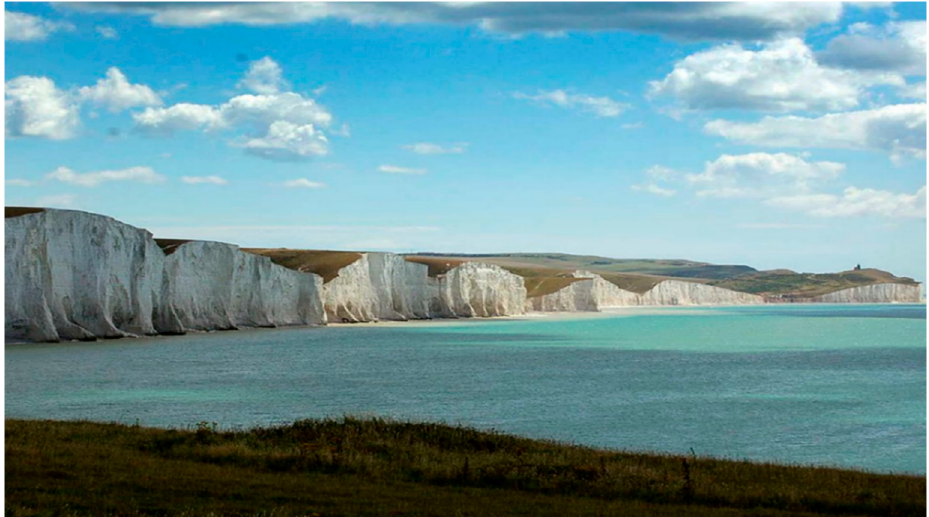
Figure 18. Seven Sisters cliff, East Sussex (4 km long × 75 m high).